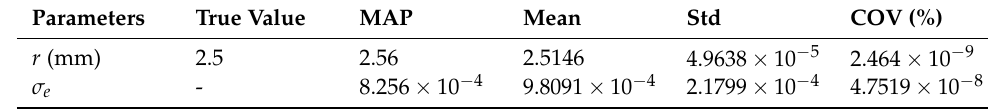
Table 2. Identified results of the numerical case from full FE.